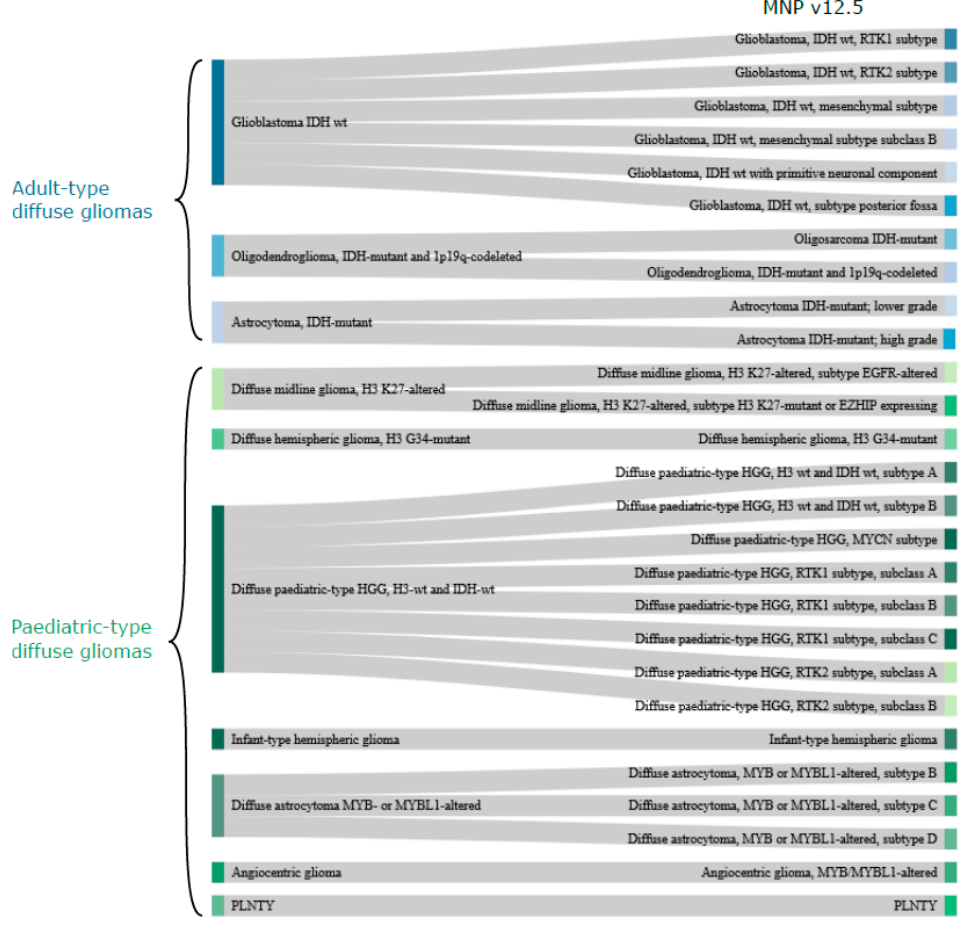
Figure 1. CNS WHO 2021 vs. methylation-based classification . Sankey plot illustrating the rela- tionship between CNS WHO 2021 classification (left) of diffuse gliomas with the MNP methylation subclasses (classifier v12.5; right) based on the description and naming of the methylation subclasses (https://www.molecularneuropathology.org/mnp/classifiers/11; accessed on 11 November 2022). Note that adult-type gliomas (blue colours for the different tumour types) are most common in adults, but may occur less frequently in children and, likewise, that paediatric-type gliomas (shown in green colours for the various types) may occur in adults. There is no methylation subclass directly corresponding to the CNS WHO diffuse low-grade glioma, MAPK pathway-altered category and this is, therefore, not included in the plot. Abbreviations: wt—wildtype, HGG—high-grade glioma. PLNTY—polymorphous low-grade neuroepithelial tumour of the young, EZHIP—enhancer of zest homologs inhibitory protein, MYCN—MYCN proto-oncogene, bHLH transcription